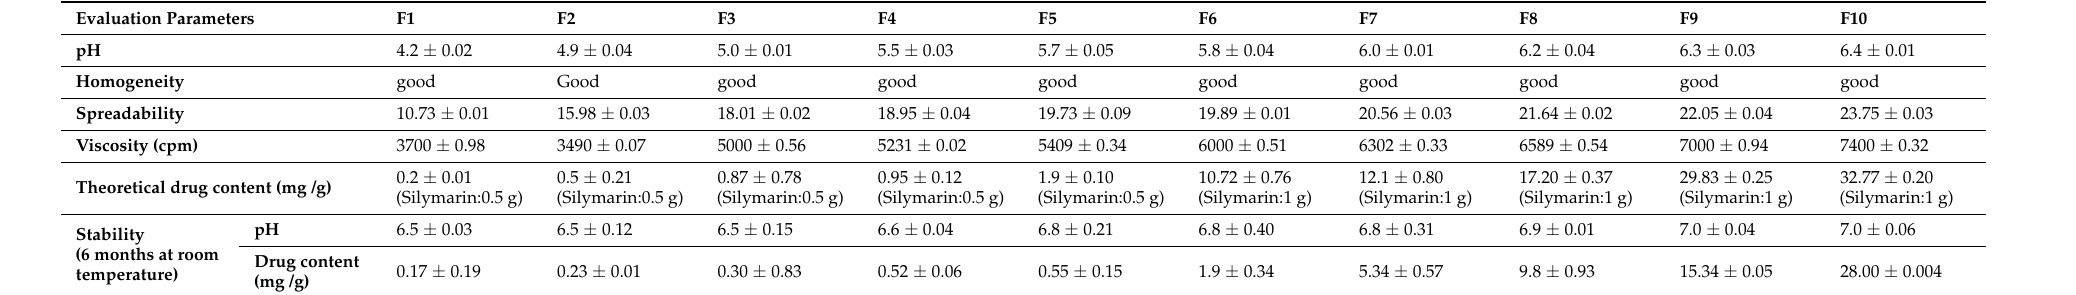
Table 2. Physicochemical evaluation for various gel